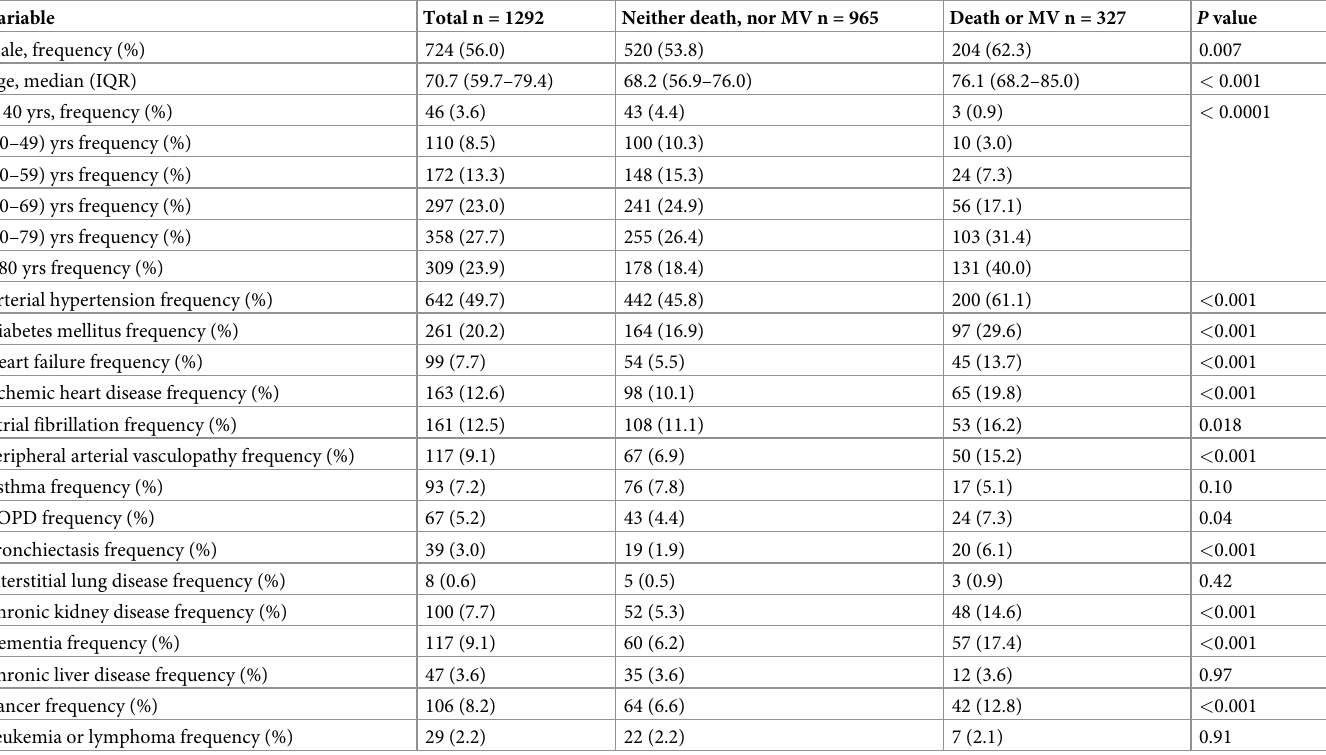
Table 1. Demographic characteristics and comorbidity data of study